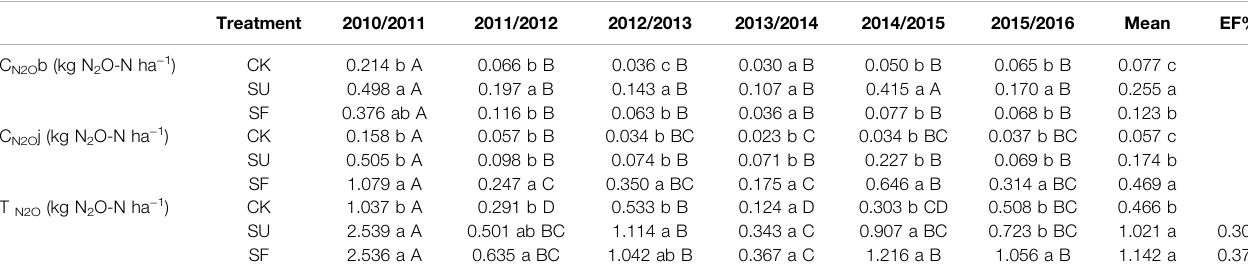
TABLE 1 | Cumulative N 2 O emission and N 2 O direct emission factor (EF) as affected by different treatments.